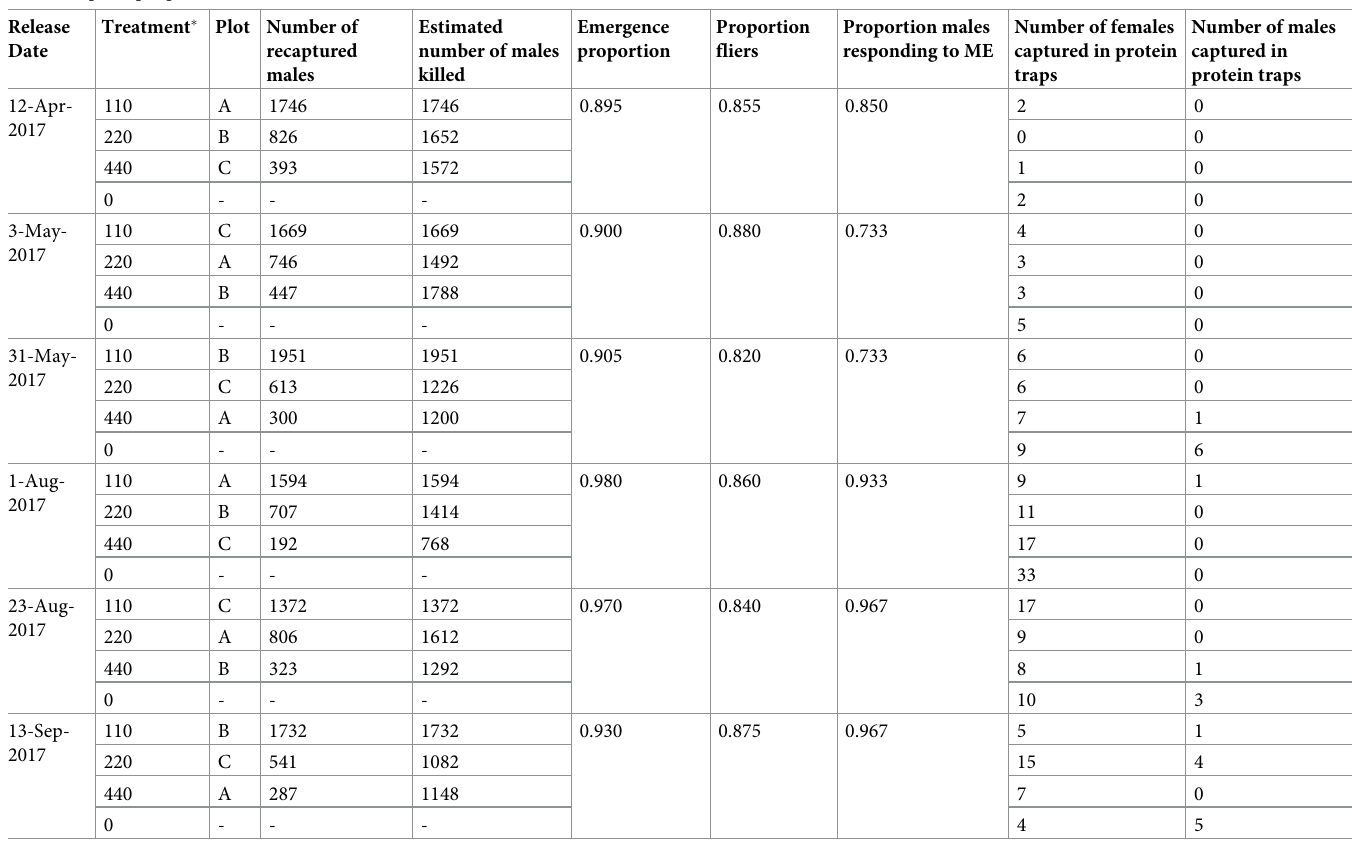
Table 2. Release, recapture and quality control data for fresh (1d old) replicates. Estimated number released in each plot based on pupal volume and an even sex ratio was 6,300 each of males and females. Considering the emergence proportion, proportion responders to ME, and proportion of fliers, the estimated number of males avail- able for capture per plot varied between 3,427 and 4,957 across